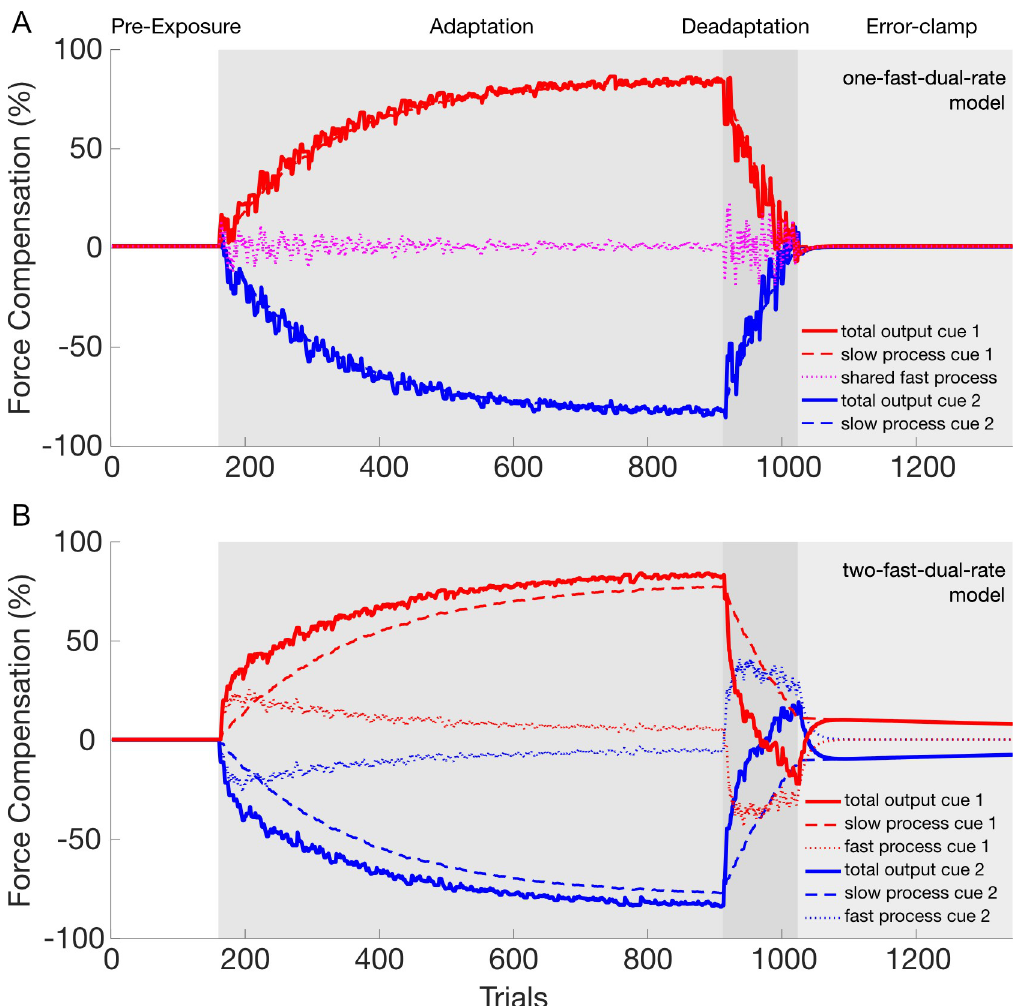
Fig 1. Simulation of the dual-rate model in dual-adaptation to compare a structure with one fast process [24] ( A ) against a structure with two fast processes ( B ). The model output of the contextual cue 1 (left workspace shift) and 2 (right workspace shift) are presented with red and blue lines, respectively. A. The dual-rate model of motor adaptation with one fast process and two slow processes. The total output for each contextual cue (red and blue thick lines) is composed of the summation of each slow process (red and blue dashed lines) and the single fast process (magenta dotted line). Note the absence of any spontaneous recovery. B. The dual-rate model of motor adaptation with two fast and two slow processes. The total output for each contextual cue (red and blue thick lines) is composed of the summation of each fast (red and blue dotted lines) and slow (red and blue dashed lines) process. Note that spontaneous recovery is revealed for both contextual cues in the error-clamp phase.